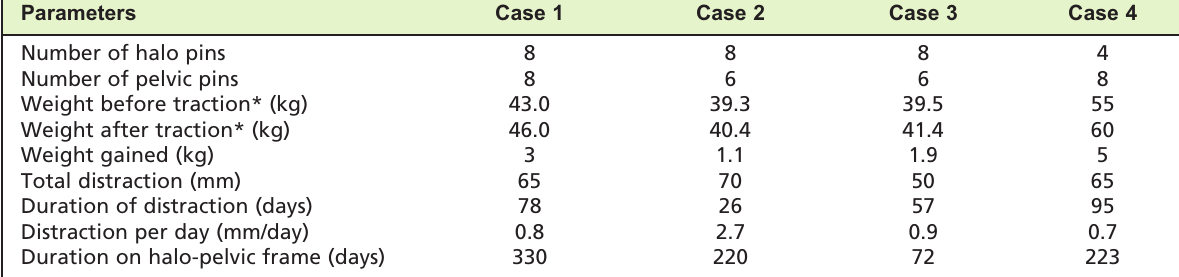
Halo-Pelvic Traction Table II: